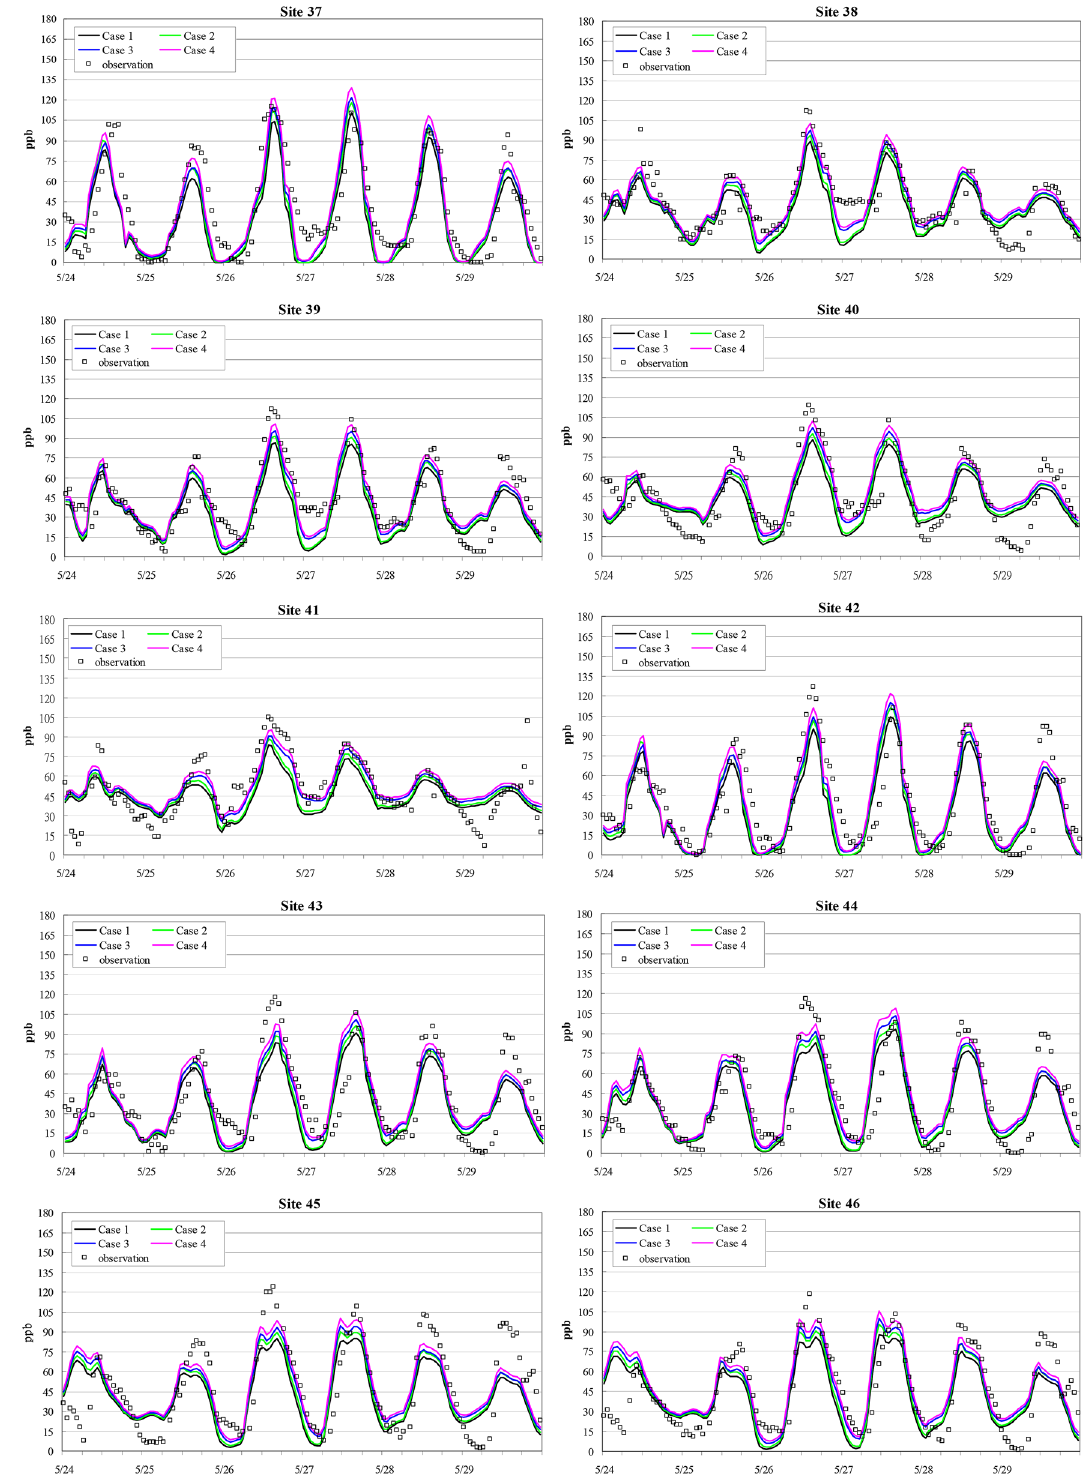
Figure 3. Time series of the simulated and observed ozone concentrations in Cases 1 to 4 at the different monitoring stations located in southern Taiwan during the 6-d period from May 24 to 29,